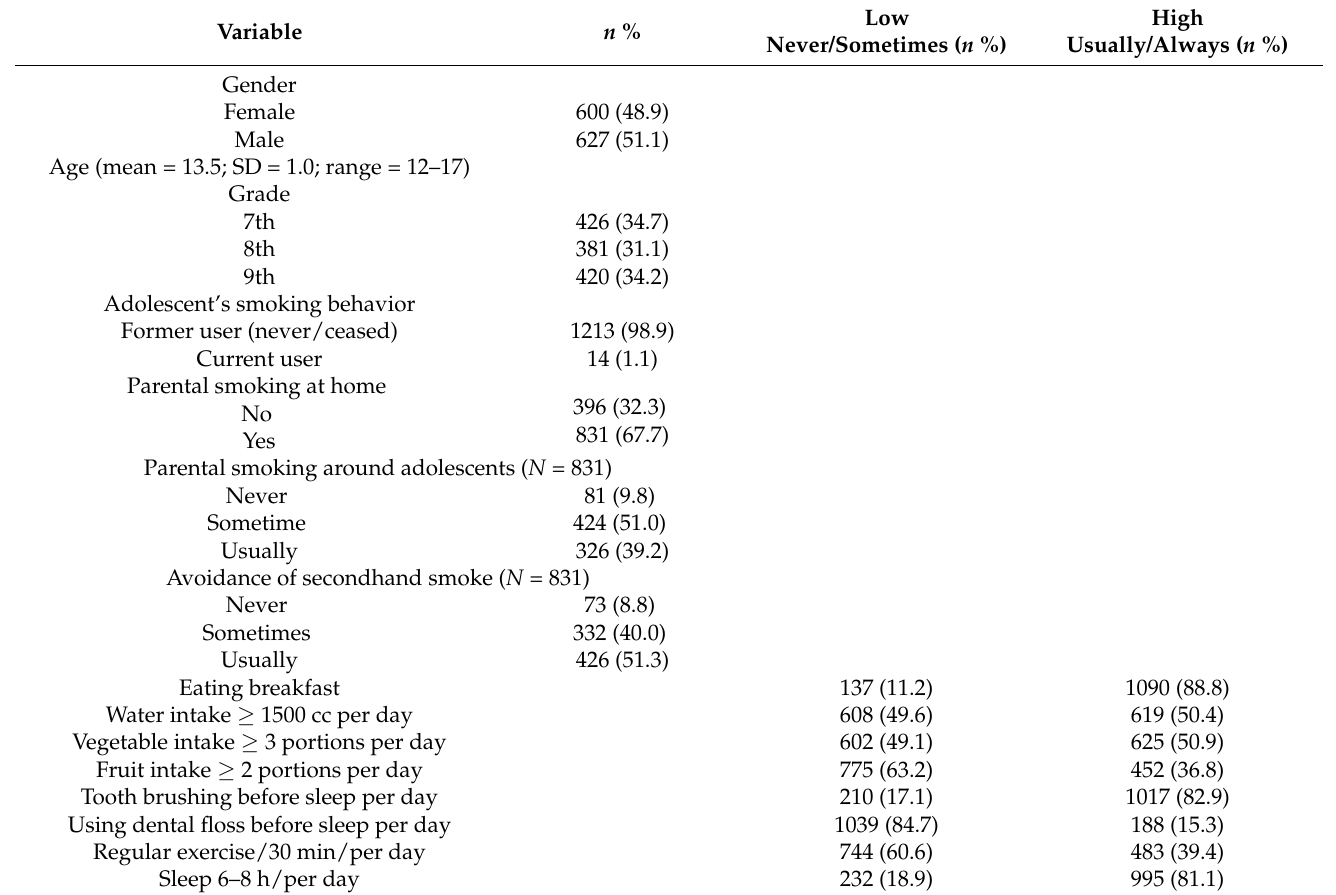
Table 1. Demographic characteristics of the participants ( n =